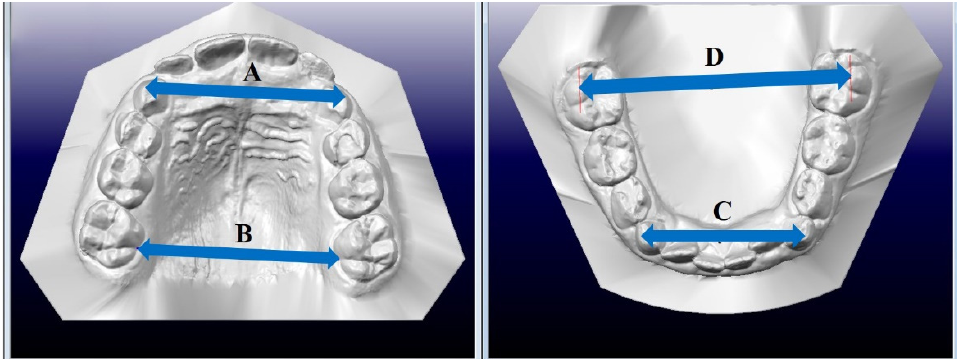
Figure 2. Measurement of the width of the dental arch. A—anterior width of the upper arch, B— posterior width of the upper arch, C—anterior width of the lower arch, D—posterior width of the lower arch. [Own source].